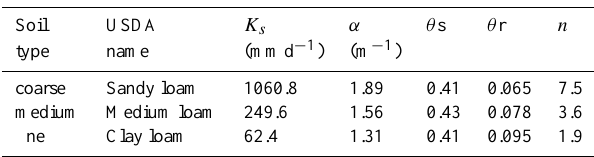
Table 1. Soil types and their hydraulic characteristics in OR-